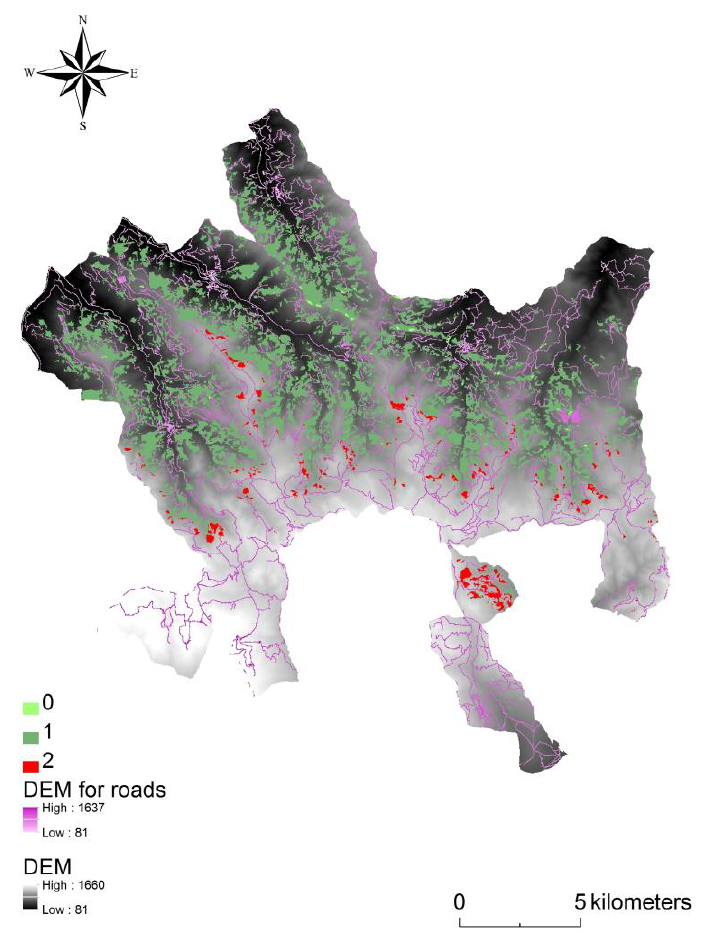
Figure 4. Possibility of mechanization. Legend 0: optimal areas for hazelnut, with minimal risk for operators; 1: favorable areas for hazelnut with good altitude and slopes. 2: areas to be avoided for greater risk for operators, including high altitude and slopes and road systems with strong slopes. Source: own elaboration.